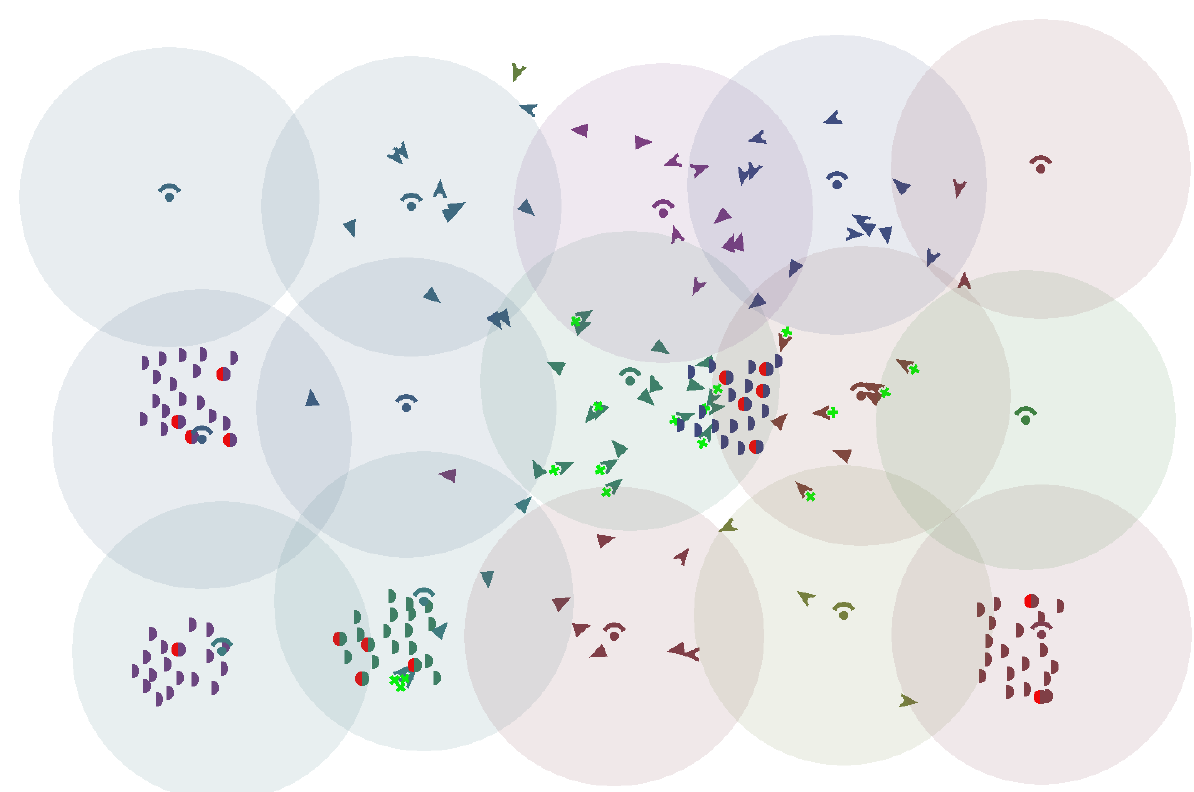
Figure 4. Wildlife monitoring simulation screenshot. The “wi-fi” like symbol represents a Station node. Each Station has an influence area (displayed with a colored circle). Mobile nodes are represented with a triangle. Healers have a half-moon on the shorter side. When healers have an animal target, a green cross appears. Animals are drawn as a half-circle. Each group has a uniform color. When they turn in danger, a half red circle comes